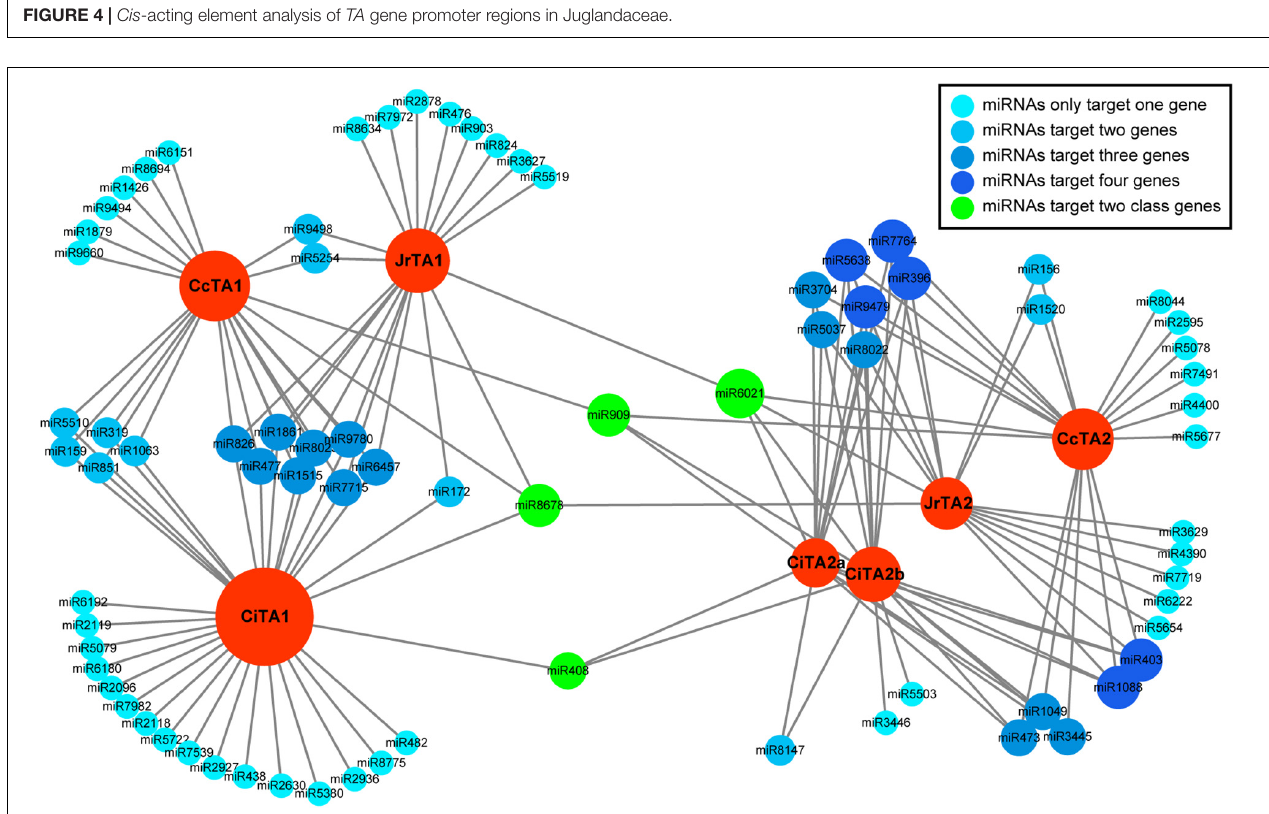
FIGURE 4 | Cis -acting element analysis of TA gene promoter regions in Juglandaceae.